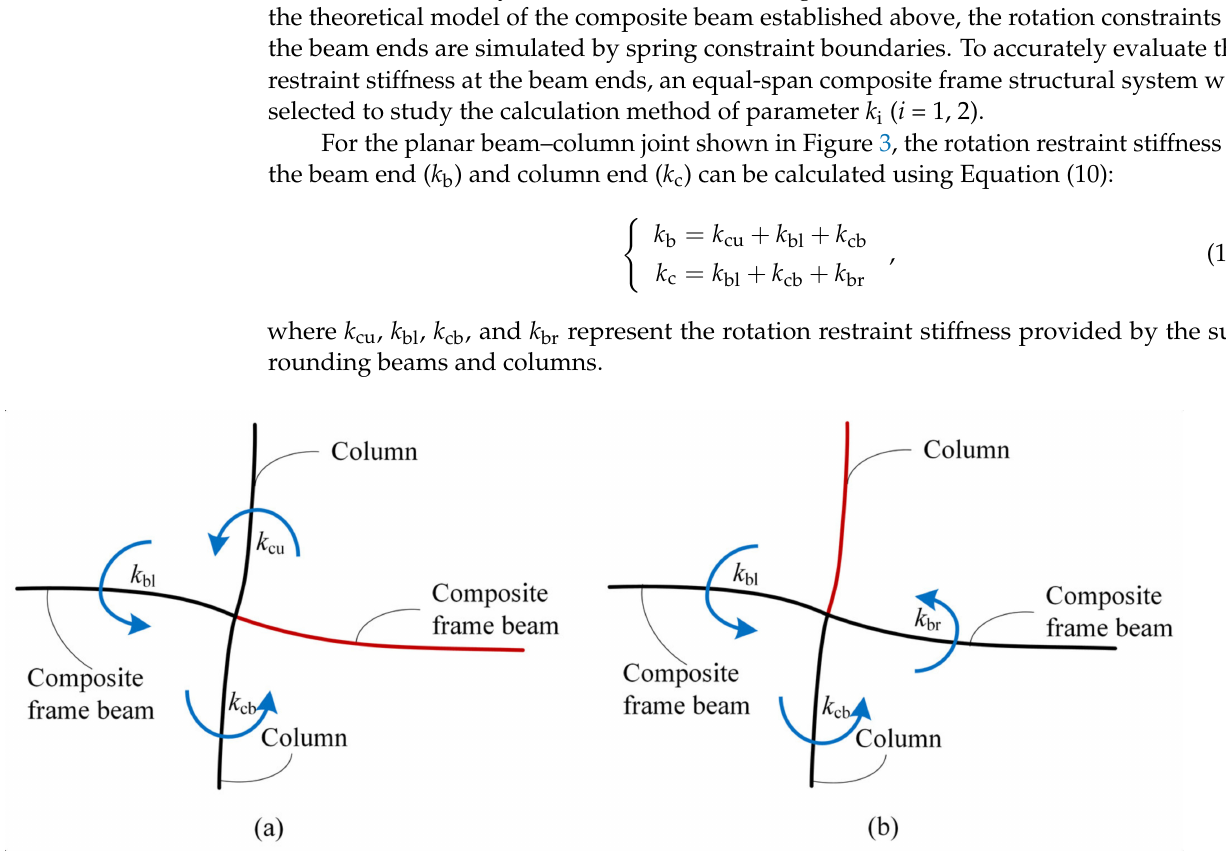
Figure 3. Composition of end rotation constraints stiffness of the beams and columns in the frame. (( a ) Rotation constraints at beam ends; ( b ) Rotation constraints at column